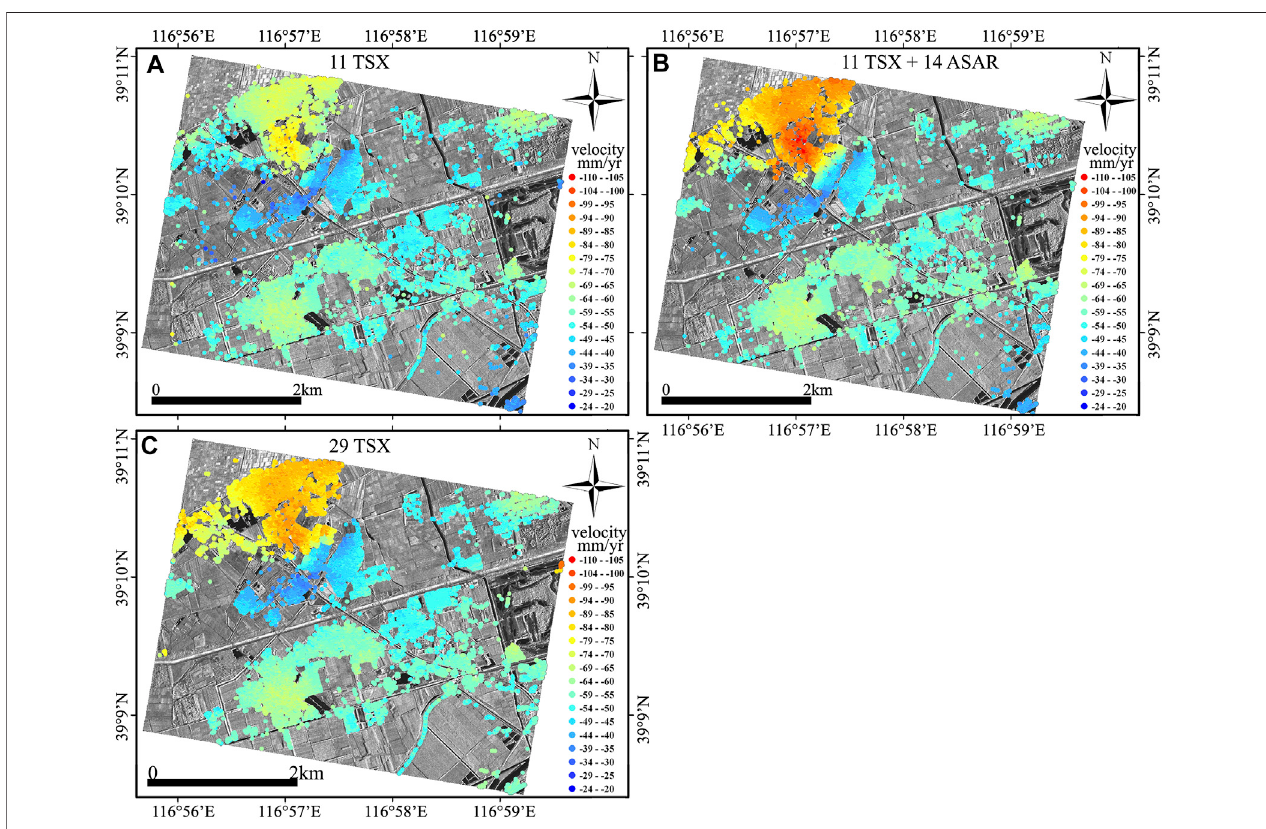
FIGURE6| Deformation ratederivedfrom (A) 11TSX acquisitions using thestandard StaMPS approach, (B) 11TSXacquisitionsand 14ASARacquisitions using the proposed method, and (C) 29 TSX acquisitions using the standard StaMPS approach.